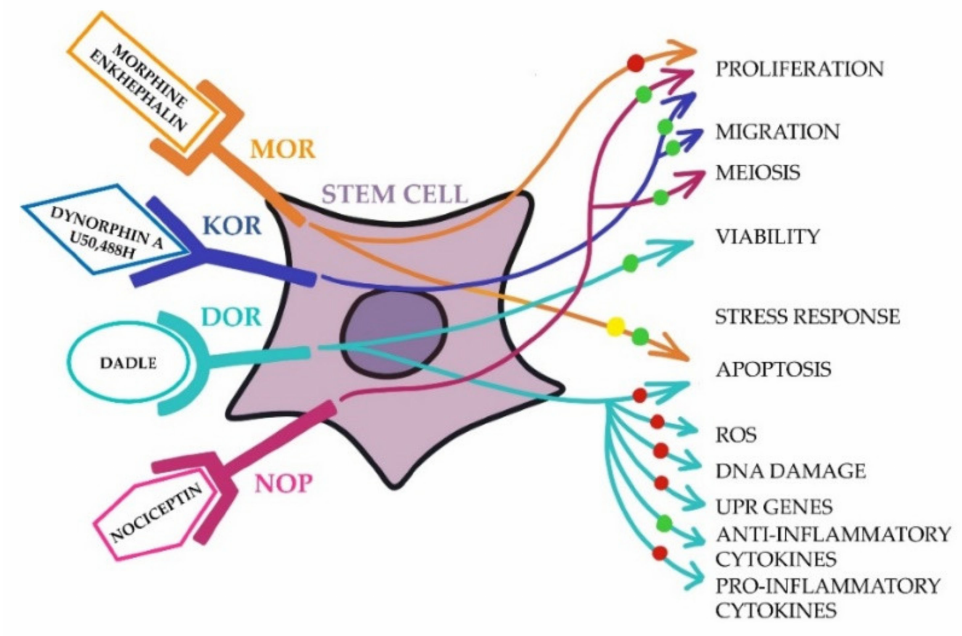
Figure 2. Schematic representation of the opioid receptors’ (MOR, KOR, DOR, and NOP) role in stem cell (SC) proliferation and stress response. Receptor agonists and cell responses written in the figure are obtained from the manuscript information. ”Stem cell” represents all types of SC (or SC-derived progenitors) described in the manuscript. All specifications written under “stress response” indicate the activities investigated in the context of the stress response. Red circle: inhibition; green circle: promotion; yellow circle: not conditioning; MOR: µ opioid receptors; KOR: κ opioid receptors; DOR: δ opioid receptors; NOP: nociception/orphanin FQ receptor; ROS: reactive oxygen species; UPR: unfolded protein